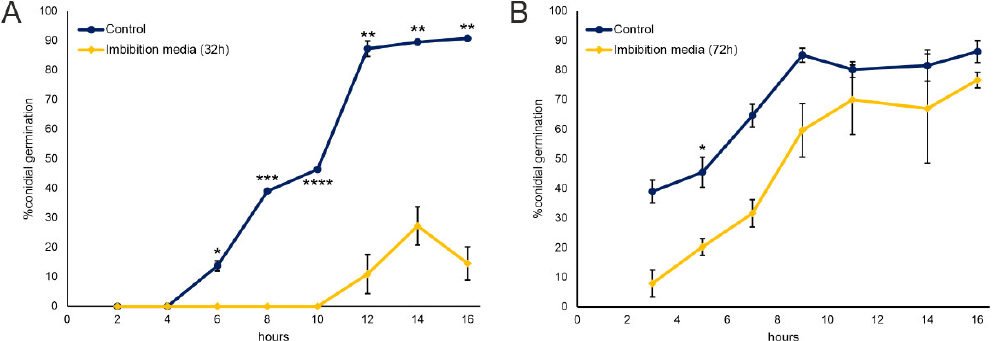
Figure 1. F. verticilloides conidial germination in presence of 32 h ( A ) and 72 h. ( B ) Nostrano di Storo seeds imbibition media. Results are reported as percent of germinated conidia with respect to total conidia ± standard deviation. Statistical differences were assessed with a Student’s T-test * p < 0.05, ** p < 0.01; *** p < 0.001; **** p < 0.0001.